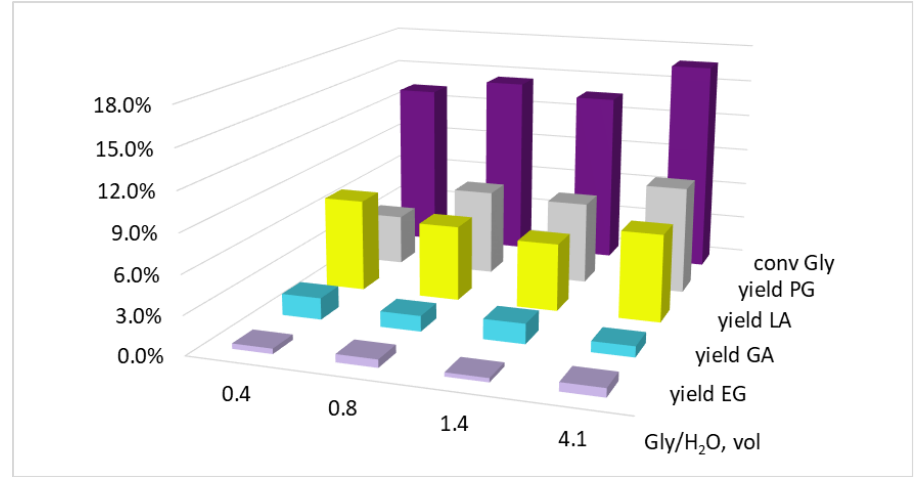
Figure 4. The influence of the Gly/H2O volume ratio on the glycerol conversion and the yields of the products. Conditions: T = 220 °C, p(H2) = 3.0 MPa, KOH/Cu = 5.8 mol, Gly/Cu = 50 mol, τ = 5.0 h, precursor salt = Cu(OAc) 2 .